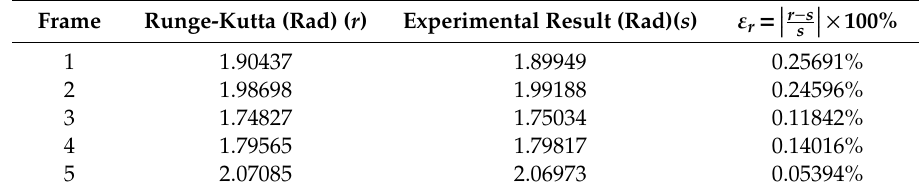
Table 3. Estimation percentage relative error ε r on knee angle for the professional parachutist between Runge-Kutta analysis r and experimental result s